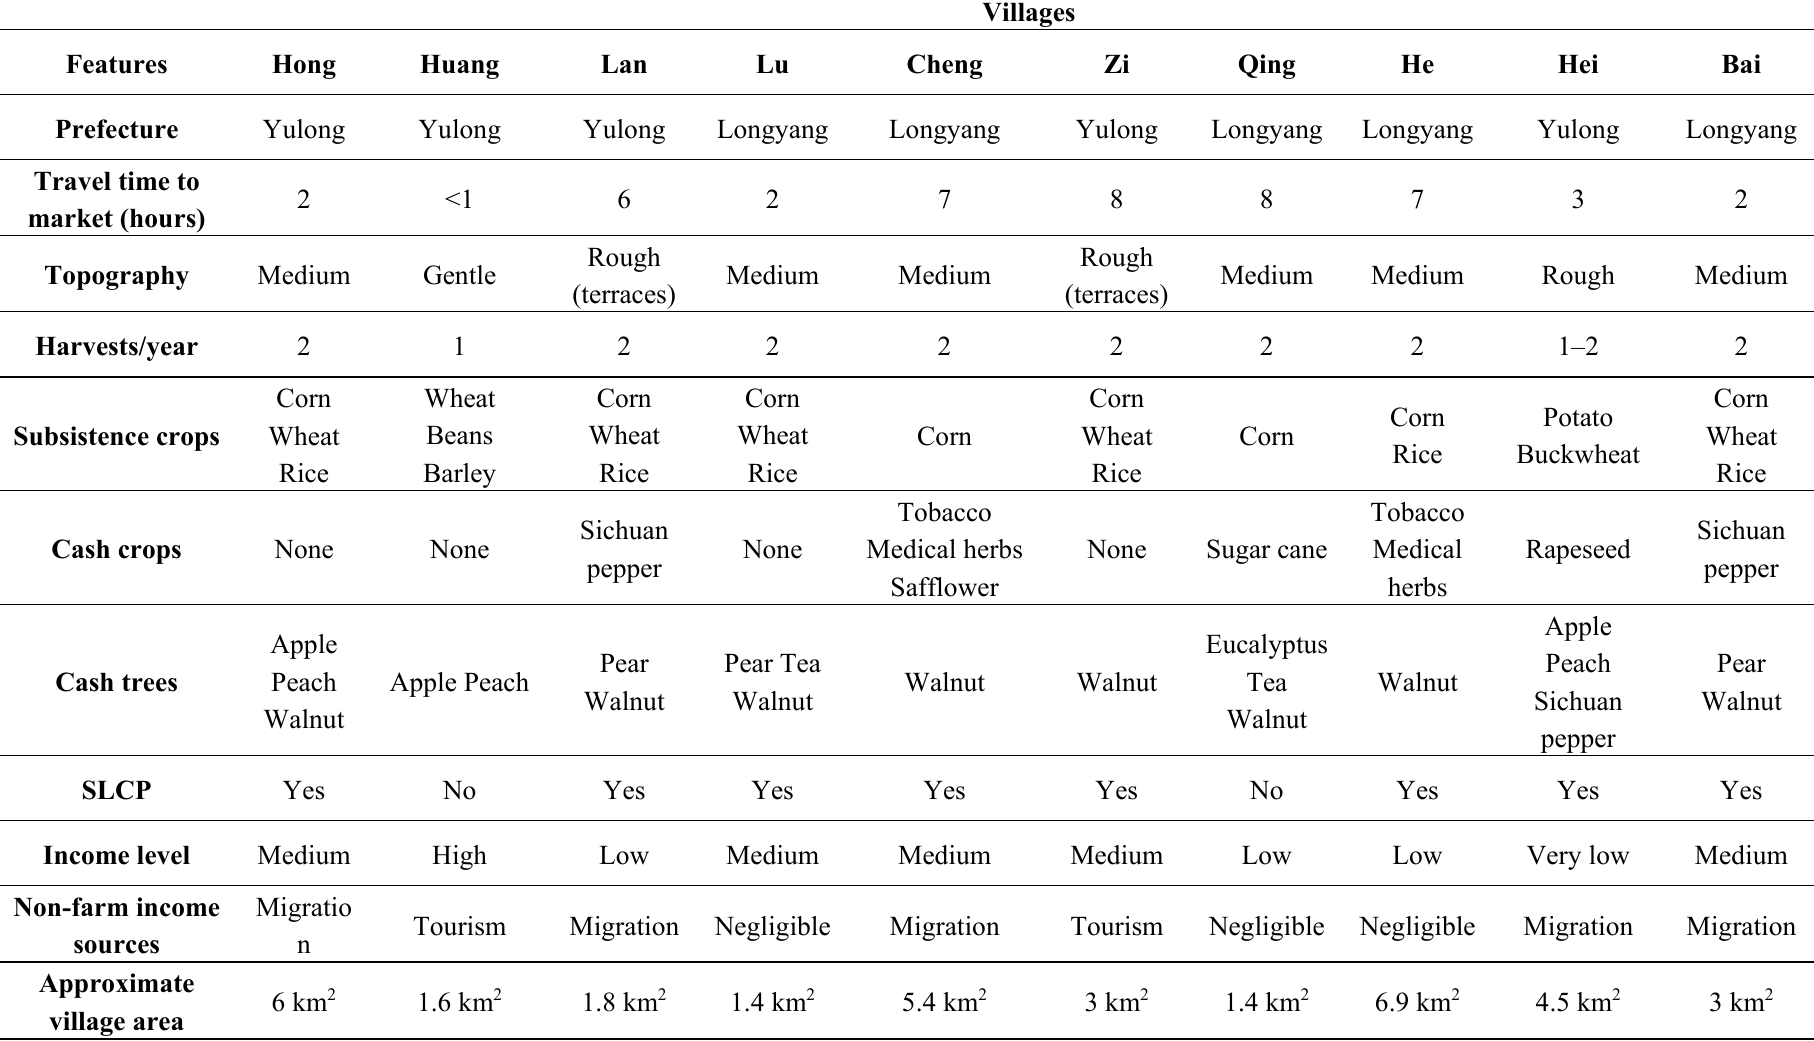
Table 1. Village